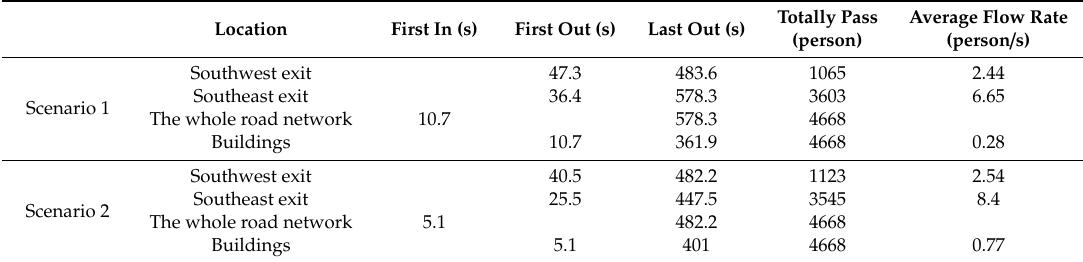
Table 9. A summary of the simulation results under two